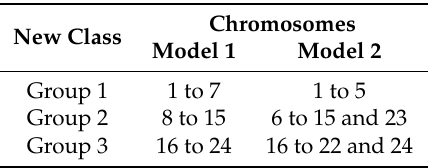
Table 5. Redefinition of the initial two-stage model. Chromosomes New Class Model 1